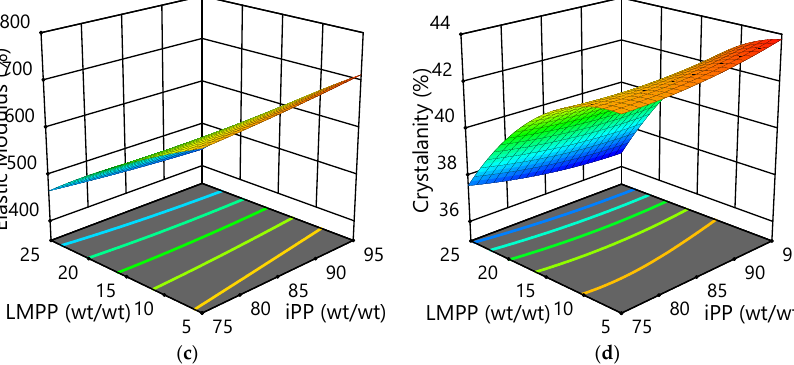
Figure 3. 3D surface plots for the effects of LMPP on iPP/LMPP blend fibres for: ( a ) elongation, ( b ) tensile strength, ( c ) elastic modulus, and ( d ) crystallinity.